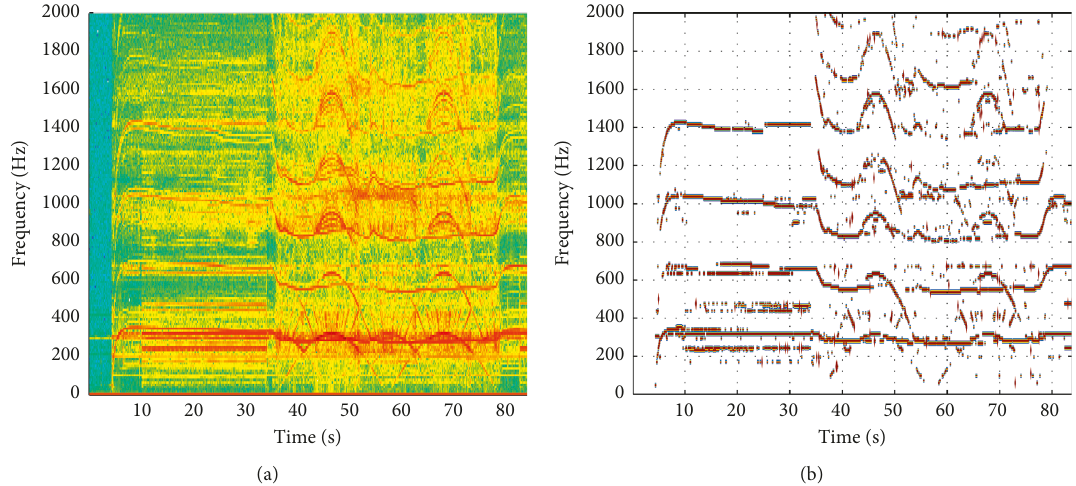
Figure 8: The spectrogram (a) with suitable peaks diagram (b) of the bed frame acceleration, for the second case of circular